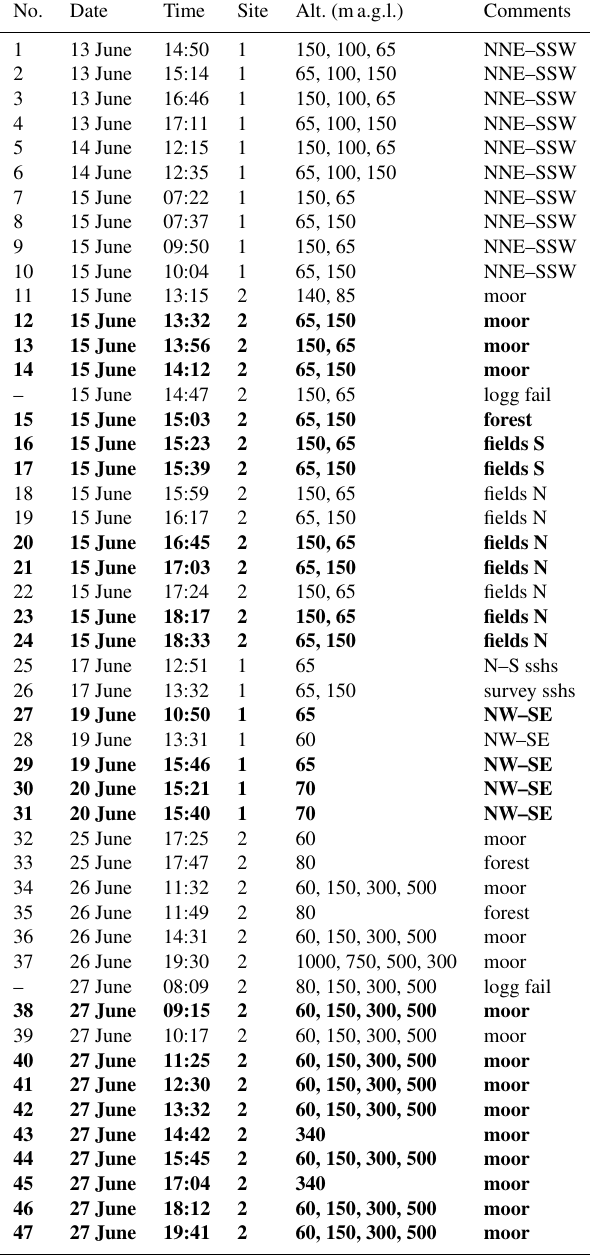
Table 1. All SUMO turbulence transects performed during the BLLAST campaign. The flights used for further analysis are shown in bold. The abbreviation “sshs” refers to the “small-scale hetero- geneity site” located at Site 1. The flight times are all in UTC, and represent the start of each